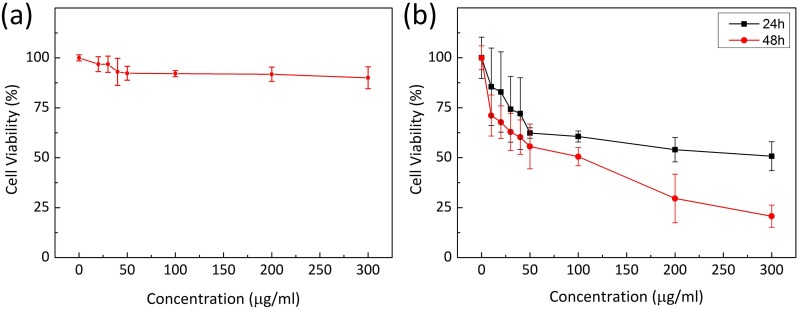
Cytotoxicity of AXT.(a) Effect of AXT on macrophage (RAW 264.7) cells after 24 h and (b) effect of AXT on VX2 cells at various concentrations (0, 10, 20, 30, 40, 50, 100, 200, 300 μg/ml) and incubation times (24 and 48 h). Each error bar represents one standard deviation.